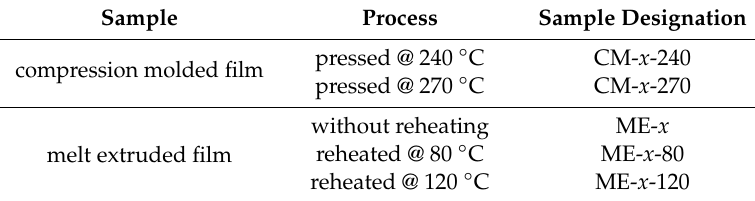
Table 1. Designation of prepared and investigated